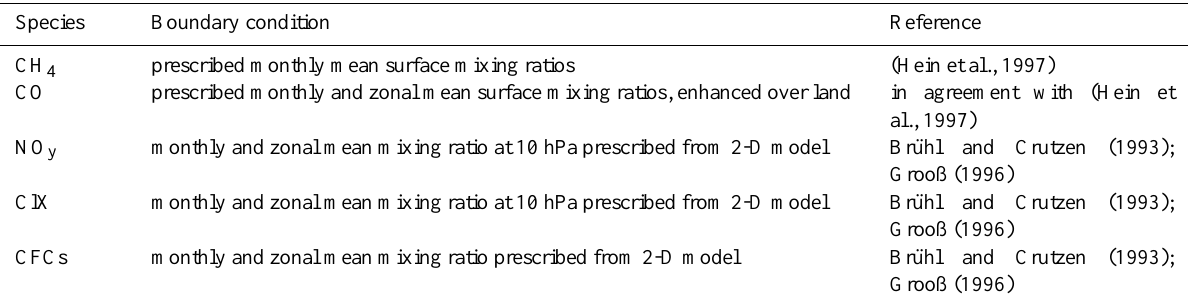
Table 3. Boundary conditions for chemical species Species Boundary condition Reference CH 4 prescribed monthly mean surface mixing ratios (Hein et al., 1997) CO prescribed monthly and zonal mean surface mixing ratios, enhanced over land in agreement with (Hein et al., 1997) NO y monthly and zonal mean mixing ratio at 10 hPa prescribed from 2-D model Br¨uhl and Crutzen (1993); ClX monthly and zonal mean mixing ratio at 10 hPa prescribed from 2-D model Br¨uhl and Crutzen (1993); CFCs monthly and zonal mean mixing ratio prescribed from 2-D model Br¨uhl and Crutzen